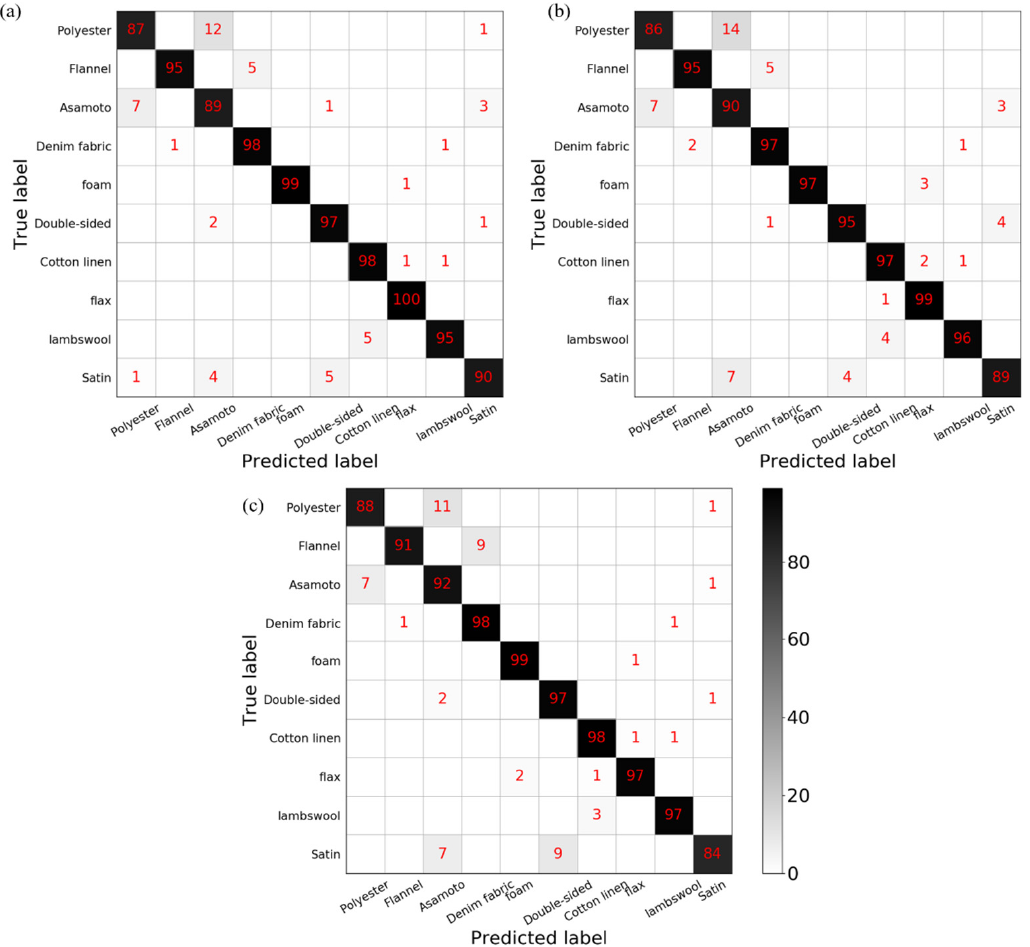
Figure 6. The confusion matrices of the three machine learning algorithms: ( a ) SVM; ( b ) RF; ( c ) KNN.